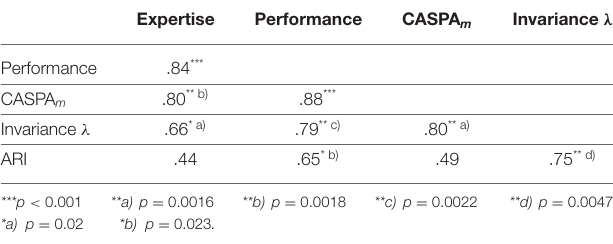
movement sequence. In deliberate practice, this